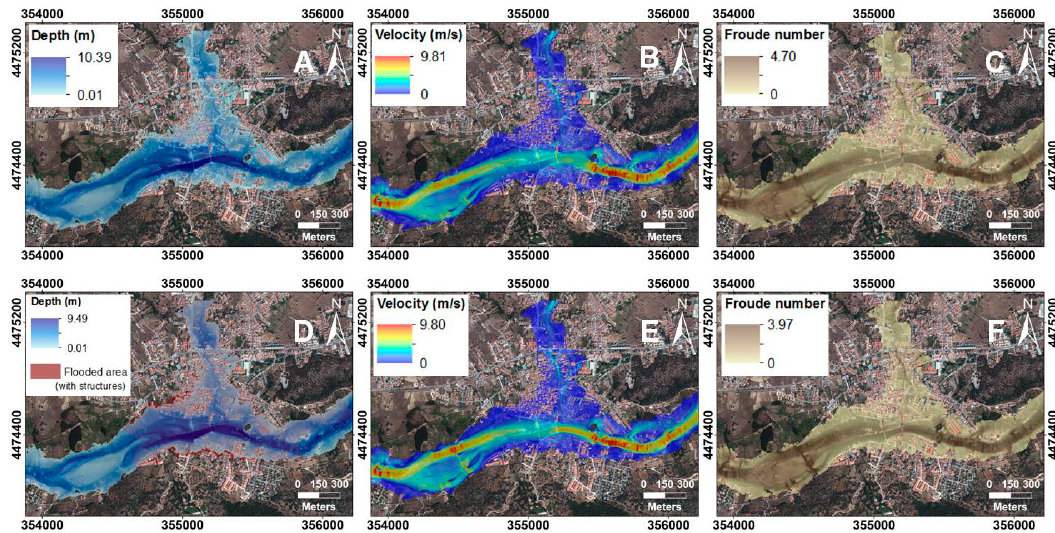
Figure 2. Some of the Iber two-dimensional hydrodynamic software outputs. ( A – C ) show depths, velocities and Froude numbers in the study area, with the existence of hydraulic structures (see Figure 1) considered as a hypothetical scenario; ( D – F ) show mapping of the same parameters but without hydraulic structures in the model.